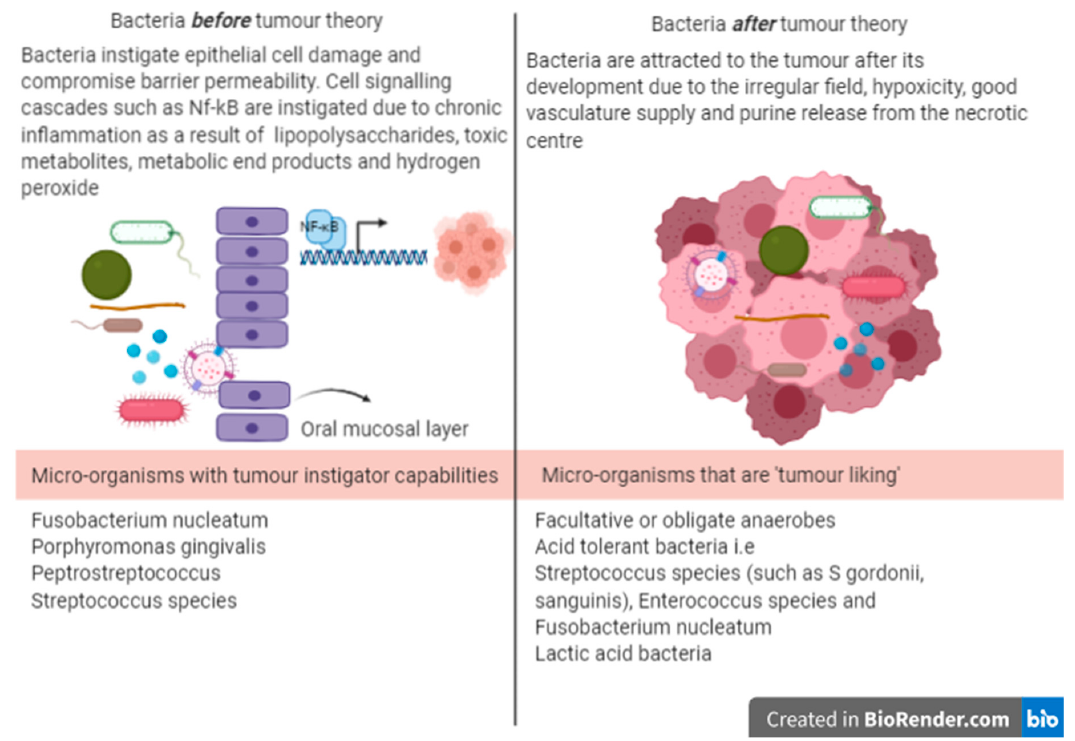
Figure 2. The possible connections between bacteria and development of oral squamous cell carcinoma (OSCC).